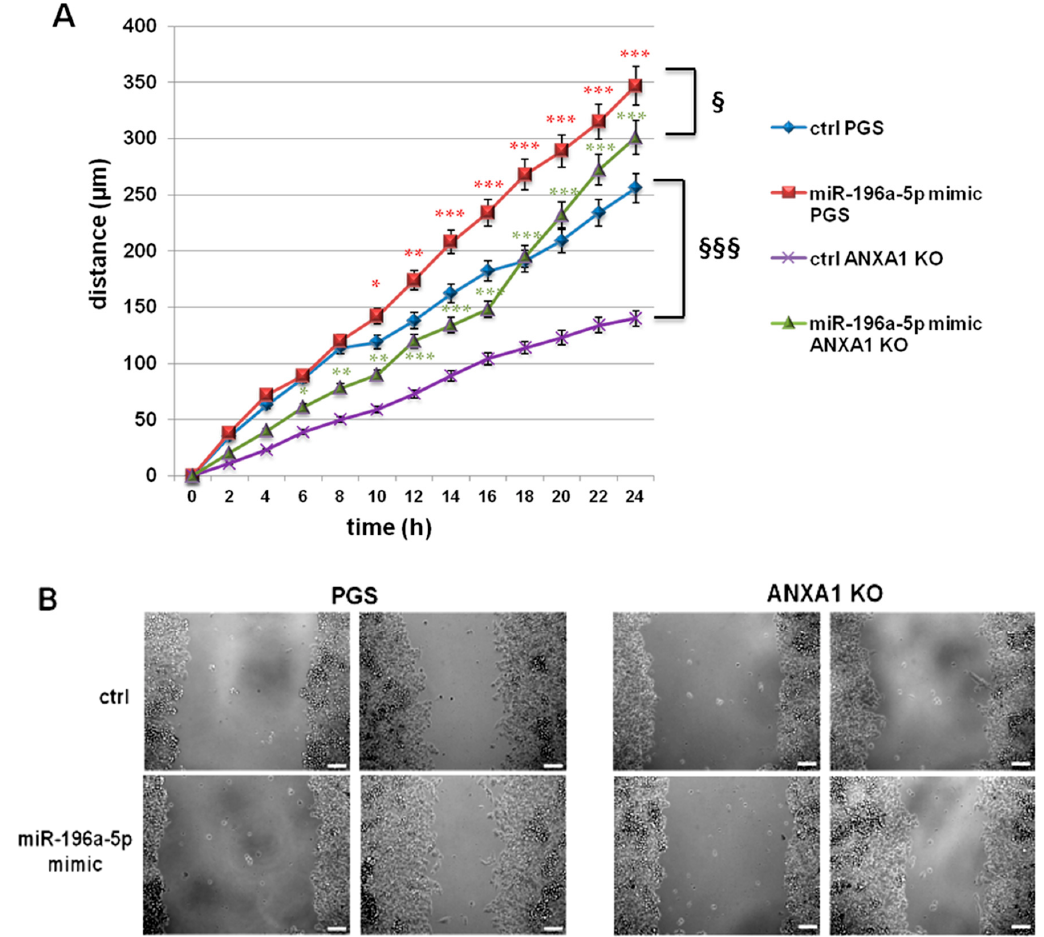
Figure 2. ( A ) Wound healing assay on PGS and ANXA1 KO MIA PaCa-2 cells; * p < 0.05, ** p < 0.01, *** p < 0.001 mimic treated vs. not treated cells. § p < 0.05, §§§ p < 0.001 ANXA1 KO vs. PGS MIA PaCa-2 cells. The migration rate was determined by measuring the distances covered by individual cells from the initial time to the selected time-points (bar of distance tool, Leica ASF software). The data are representative of three independent experiments ± SEM; and ( B ) Representative images that were captured by TIME LAPSE microscope of PGS and ANXA1 KO MIA PaCa-2 at 0 and 24 h from produced wounds. Magnification 10×. Bar: 100 µm.